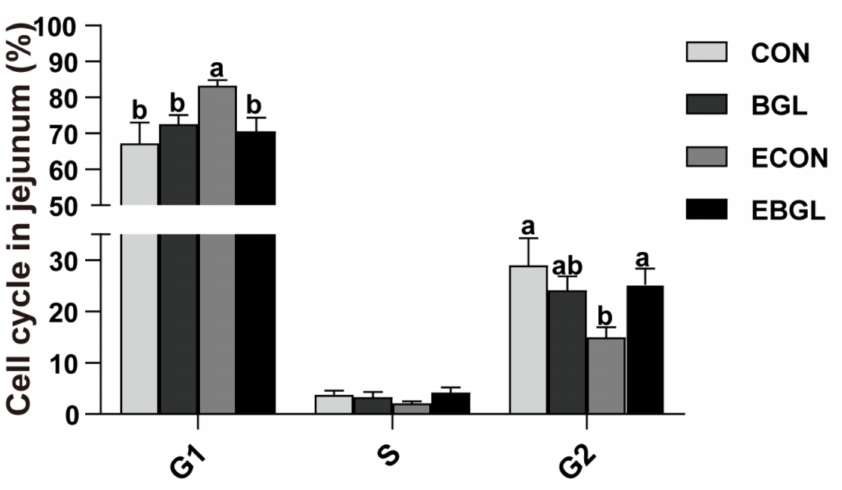
Figure 2. Effects of BGL supplementation on jejunal cell cycle (%) in weaned piglets upon ETEC challenge. a, b, values within a row with different superscript letters are significantly different ( p < 0.05). CON, pigs were fed with a basal diet; BGL, pigs were fed with a BGL-containing diet (500 mg/kg); ECON, pigs were fed with a basal diet and challenged by ETEC; EBGL, pigs were fed with a BGL-containing diet and challenged by ETEC.